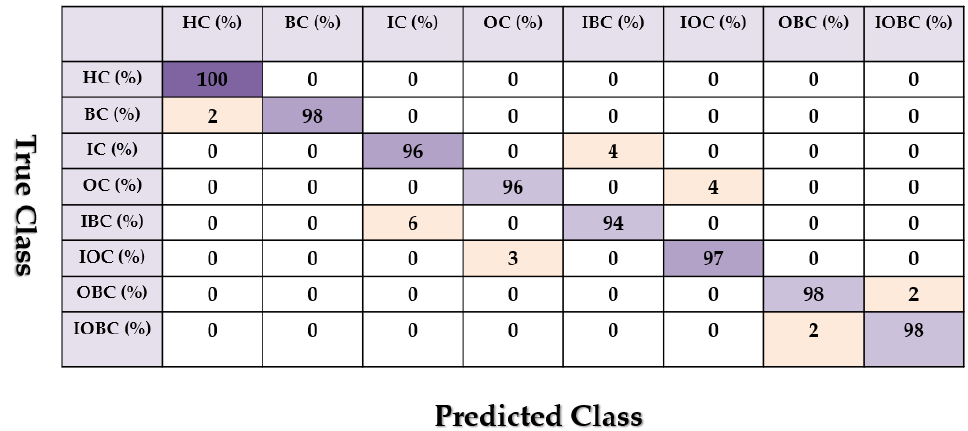
Figure 14. The average of crack type diagnosis using the combination of the ALSGL-SBI and SVM approaches.